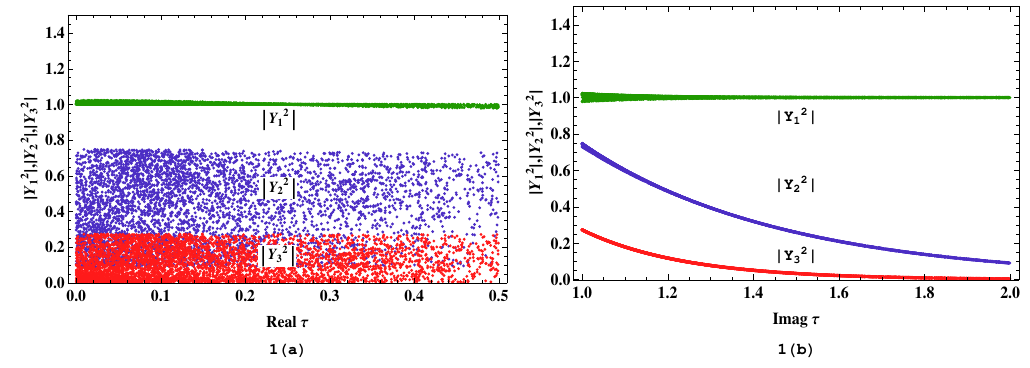
| , | Y 2 | , | Y 2 | ) with real (fig- 1 2 3